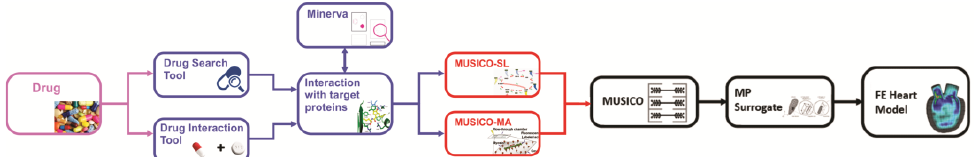
Figure 6. Scenario 2: Changes in kinetic of contractile proteins for drug action. Adopted from ref.